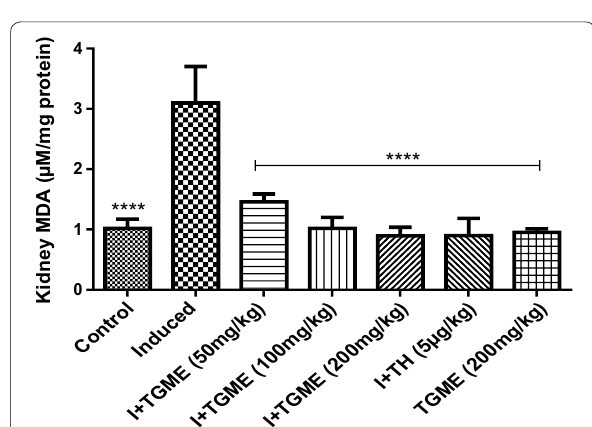
Fig. 8 Effect of aqueous methanolic leaf extract of Triclisia gilletii on MDA produced in animals administered ethane-1,2-diol. Data are expressed as mean SEM of 6 rats ( n 6); **** p < 0.0001; *denotes ± = that data were compared with ethane-1,2-diol; TGME Triclisia gilletii aqueous methanolic extract, TH tamsulosin hydrochloride, MDA malondyaldehyde